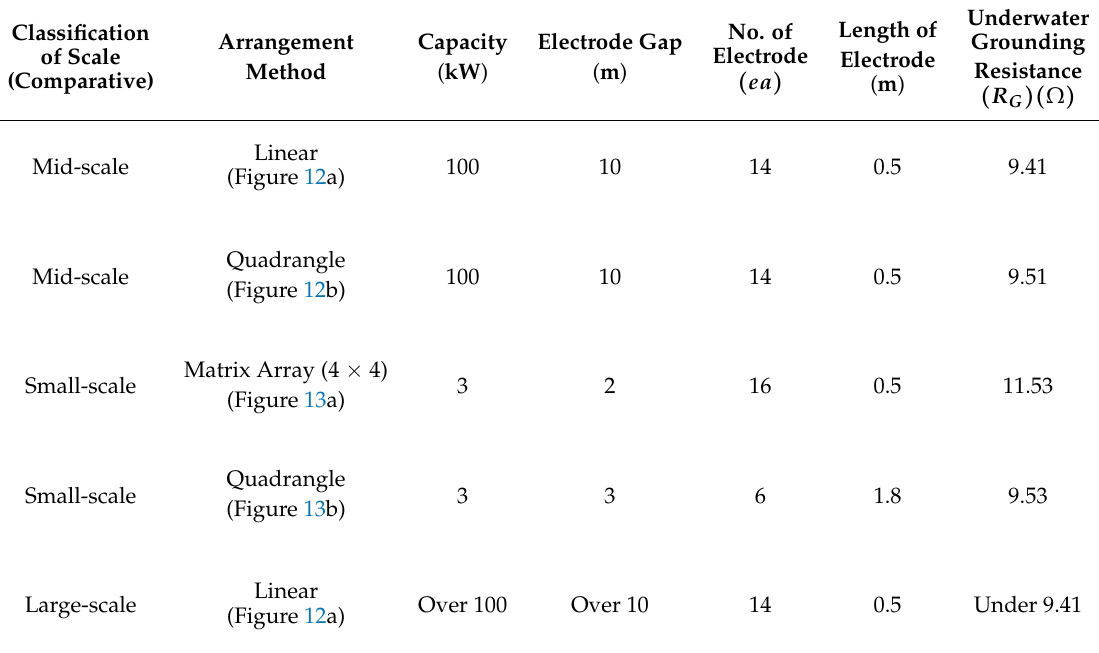
Table 2. Simulation results applied to real floating PV